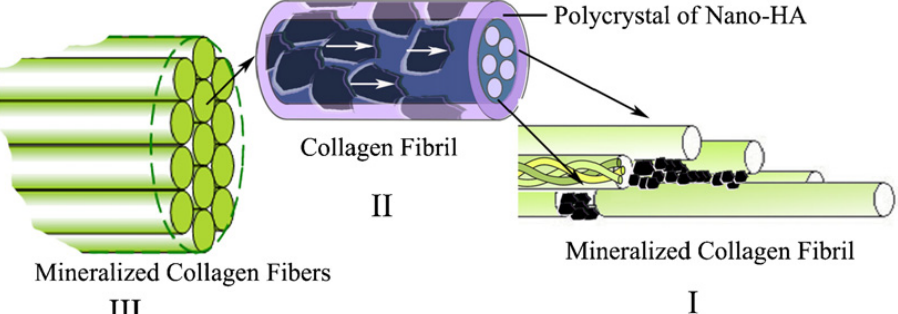
Figure 3. The hierarchical structure of the self-assembled mineralized collagen. (In I , the first level, the organization of the collagen molecules with the nano-sized HA crystals formed initially in the gap zones between the collagen fibrils; in II , the second level, showing the organization of collagen fibrils with respect to HA crystals, the HA crystals are platelet-like and grow on the surface of these fibrils in such a way that their c -axes are oriented along the longitudinal axes of the fibrils, as indicated by the white arrows in the figure; in III , the third level, showing the organization of the mineralized collagen fibrils, a number of mineralized collagen fibrils align parallel to each other to form mineralized collagen fibers. Reprinted with permission from reference [1]. Copyright 2007